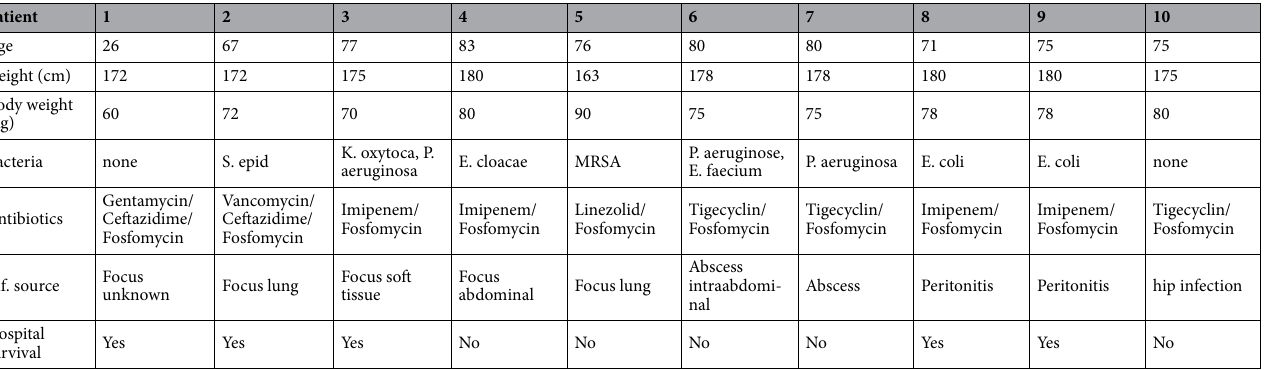
Table 1. Demographics, source of Infection and antibiotic